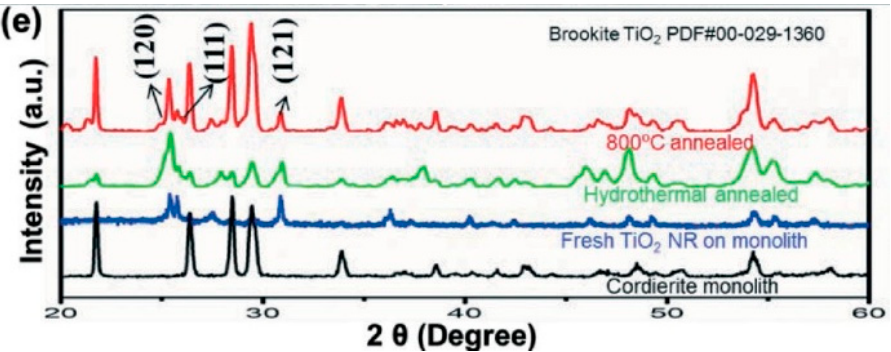
Figure 17. ( a ) Mass loss vs. time spectra of TiO 2 nanorods array annealed at 800 °C/24 h; ( b ) SEM image after 800 °C 24 h annealing; inset is the high magnification image; TiO 2 nanorods array after aging in boiling DI water at 120 °C for 24 h: SEM images of low magnification ( c ) and high magnification image ( d ); ( e ) XRD spectra of cordierite monolith, fresh TiO 2 nanorod arrays on monolith, hydrothermally aged TiO 2 nanorod arrays on monolith, and 800 °C annealed TiO 2 nanorod arrays on monolith. Reprinted with permission from [9], Copyright RSC, 2013.